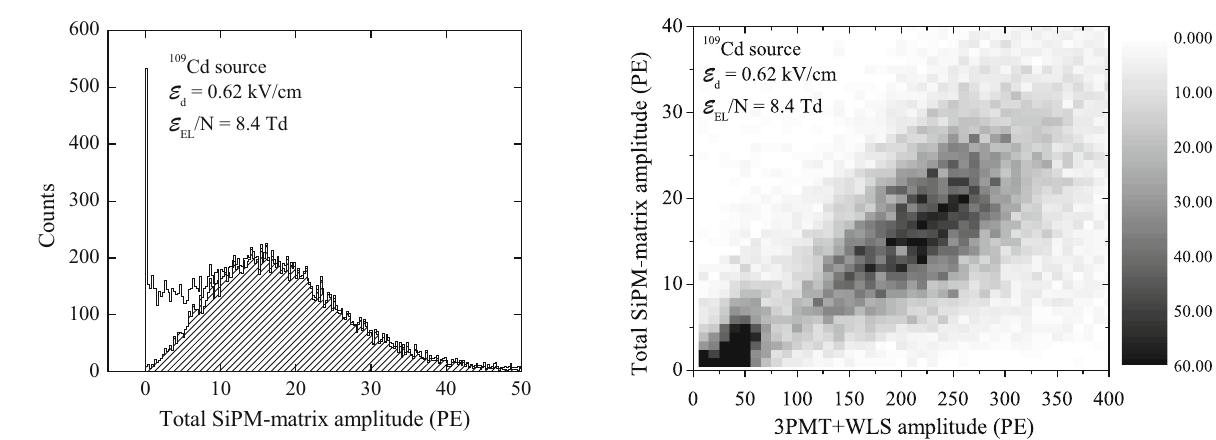
Fig. 11 Direct SiPM-matrix readout: correlation between the ampli- tude of the total SiPM-matrix and 3PMT + WLS signals